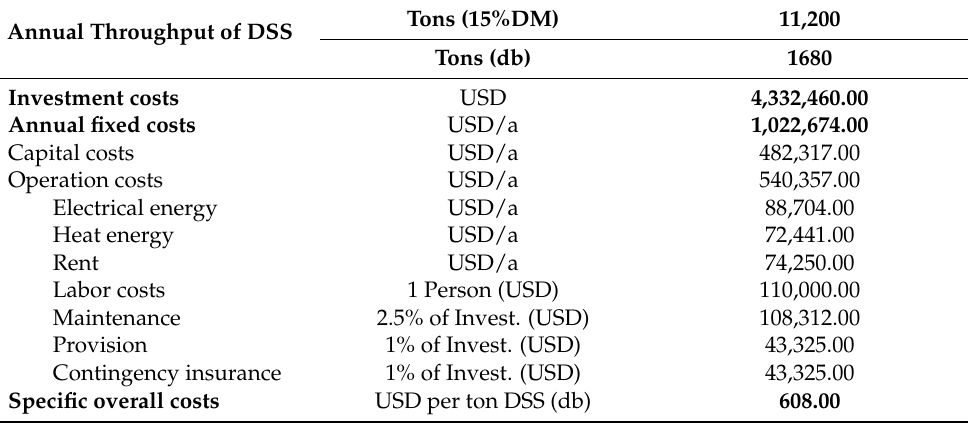
Table 4. Calculation of net costs for the HTC process from GRegio Energie AG (amortization time 10 years, interest rate 2%; db = dry basis; DSS = digested sewage